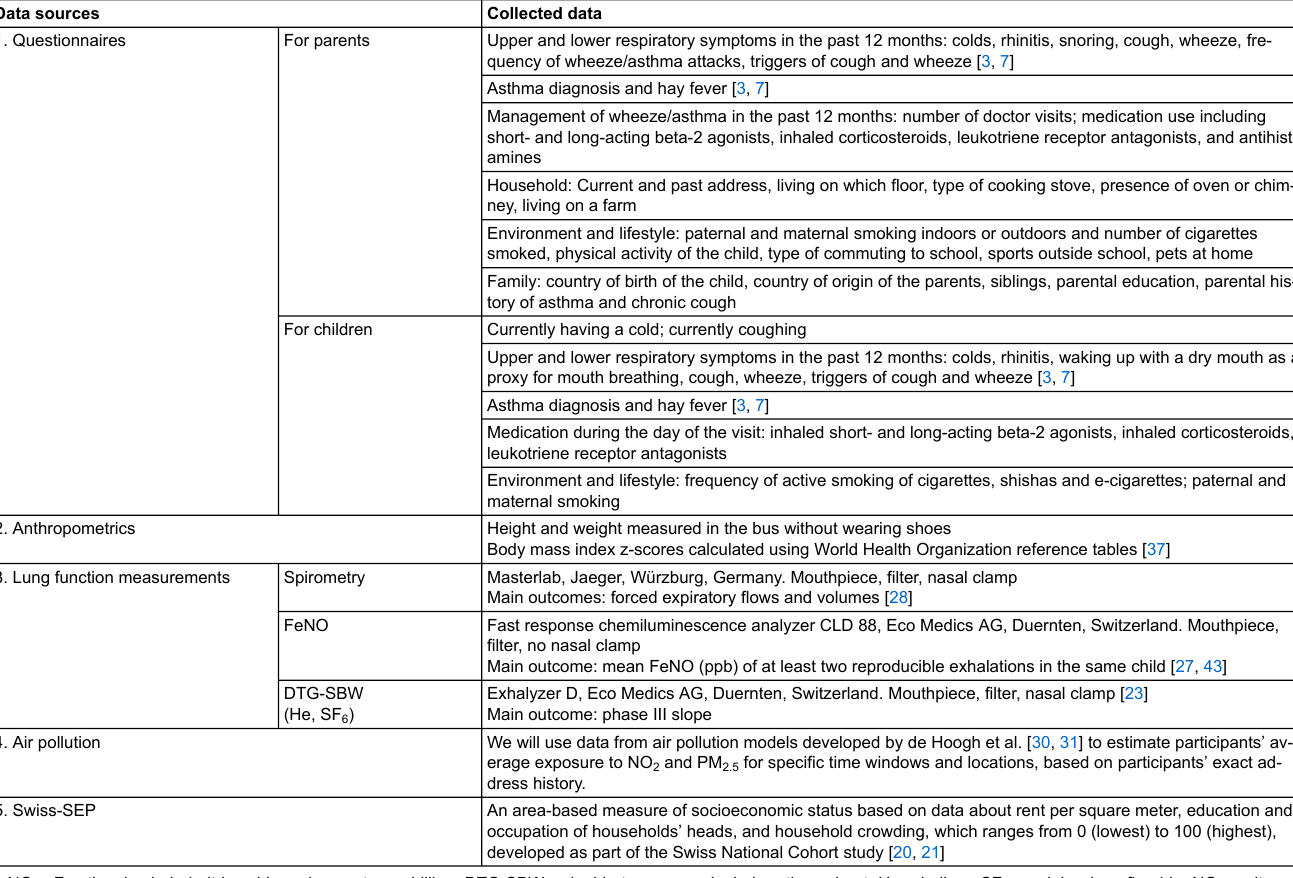
Table 1: Details of data collected in the LuftiBus in the school (LUIS) study. Data